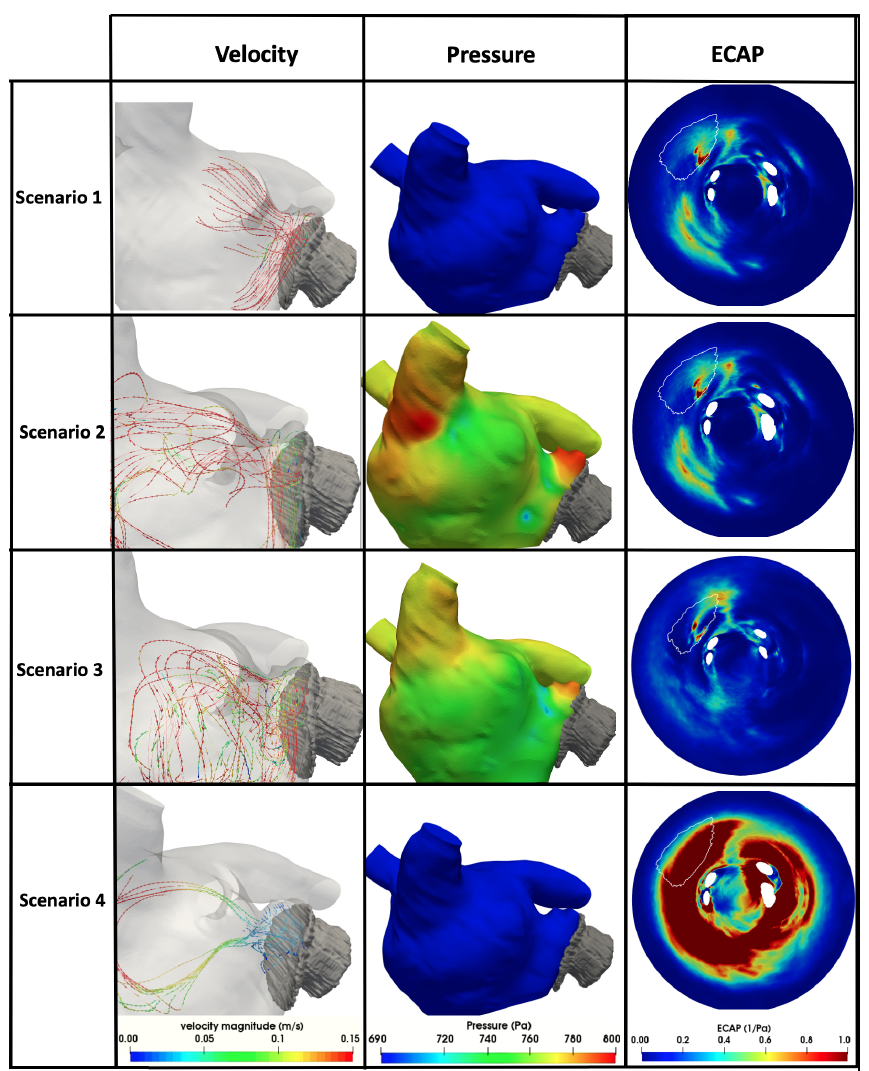
Figure 2. Haemodynamic in silico indices obtained with different boundary condition scenarios (1–4). ECAP: endothelial cell activation potential. The white line in the ECAP maps indicates the position of the implanted device. Scenario 1: null inlet pressure, imaging-based outlet velocities, and rigid wall; Scenario 2: as Scenario 1 but with patient pressure wave as inlet; Scenario 3: as Scenario 2 but with dynamic mesh wall deformation; Scenario 4: literature velocity profile as inlet, mitral valve as wall (systole) or constant pressure (diastole), and dynamic mesh wall